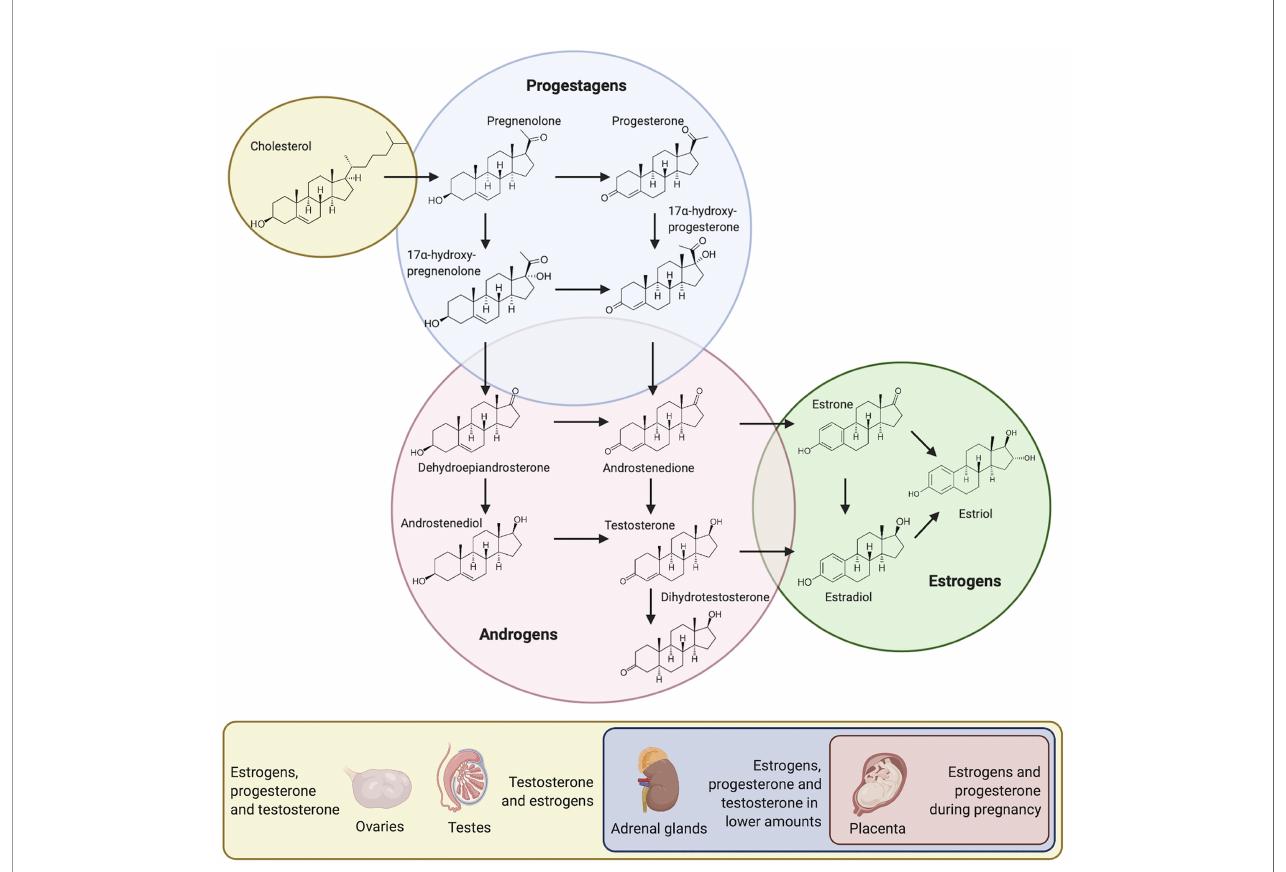
FIGURE 1 | Pathways for the synthesis of SSH and secretory organs in the human